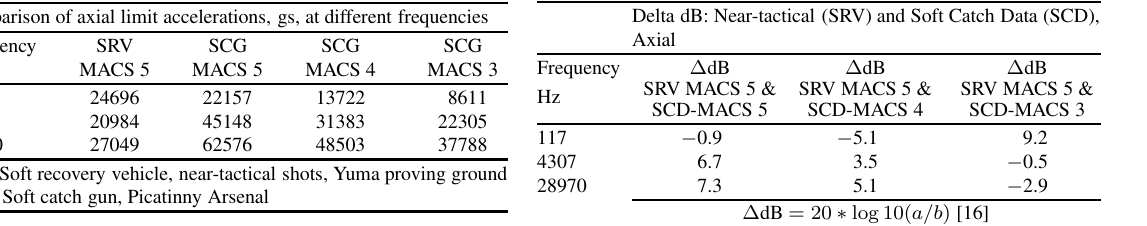
Table 2 Comparison of 95/50 normal tolerance limits, axial acceleration